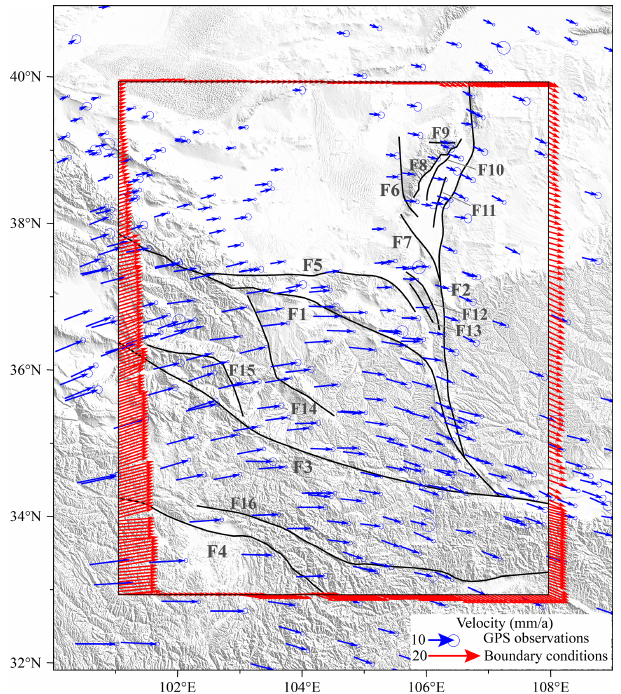
Figure 4. Model boundary conditions. The blue arrows represent the GPS observation velocities from Wang and Shen (2020). The red arrows at the boundary represent the boundary velocities calculated by the interpolation of the GPS observations. Fault names can be found in Fig.